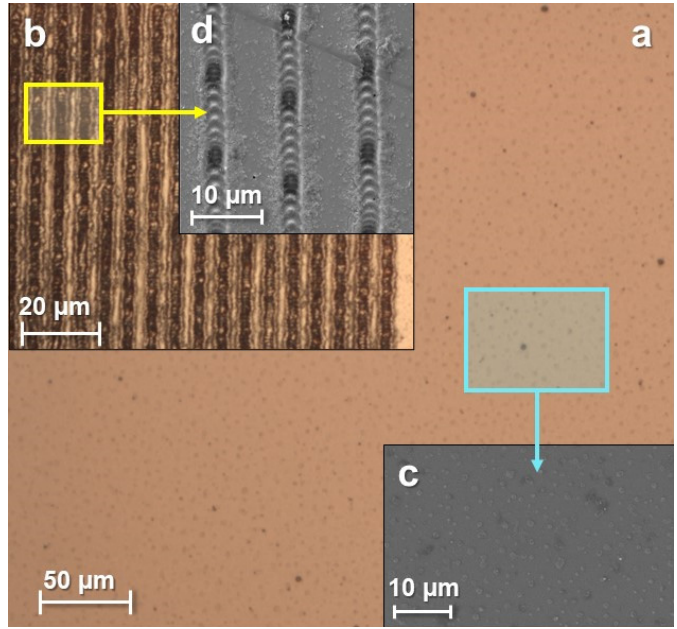
Figure 5. PbSe film optical microscopy a in a bright field of reflected light: ( a ) untreated, ( b ) after laser modification; PbSe film pictures obtained with the SEM secondary electron detector: ( c ) untreated, ( d ) after laser modification.